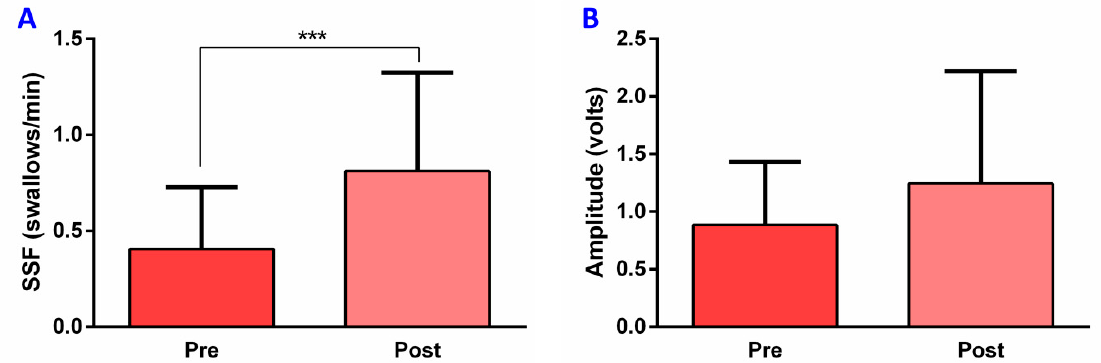
Figure 6. Capsaicin effect on SSF and EMG metrics in post-stroke dysphagia patients: ( A ) SFF, ( B ) Amplitude. SSF: spon- taneous swallowing frequency; s: seconds; pre: pre-treatment; post: post-treatment; *** p < 0.001.